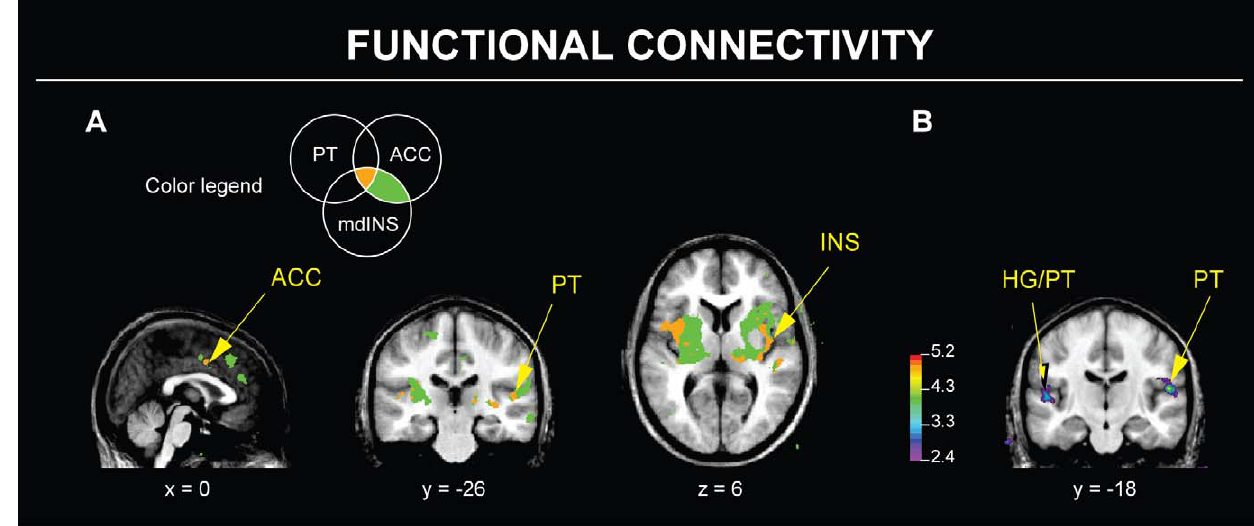
Figure 2. Functional connectivity during simple singing before and after training. A: The different overlap patterns between three connectivity maps during simple singing, generated with seed voxels in right planum temporale (MNI/ICBM152 world coordinates 52, 2 20, 6), right mid-dorsal insula (40, 4, 6), and left ACC BA 24 ( 2 2, 4, 44); all voxel p s # 0.001, uncorrected. The Venn diagram above depicts the color legend used to show overlap in connectivity maps. B: After training, the right planum had stronger connectivity with an adjacent region of right planum and the cortex of the left Heschl’s sulcus, which contains Heschl’s gyrus and/or planum, during simple singing. All peak/cluster p s # 0.05, corrected. ACC = anterior cingulate cortex; BA = Brodmann area; HG = Heschl’s gyrus; INS = insula; mdINS = mid-dorsal insula; PT = planum temporale.